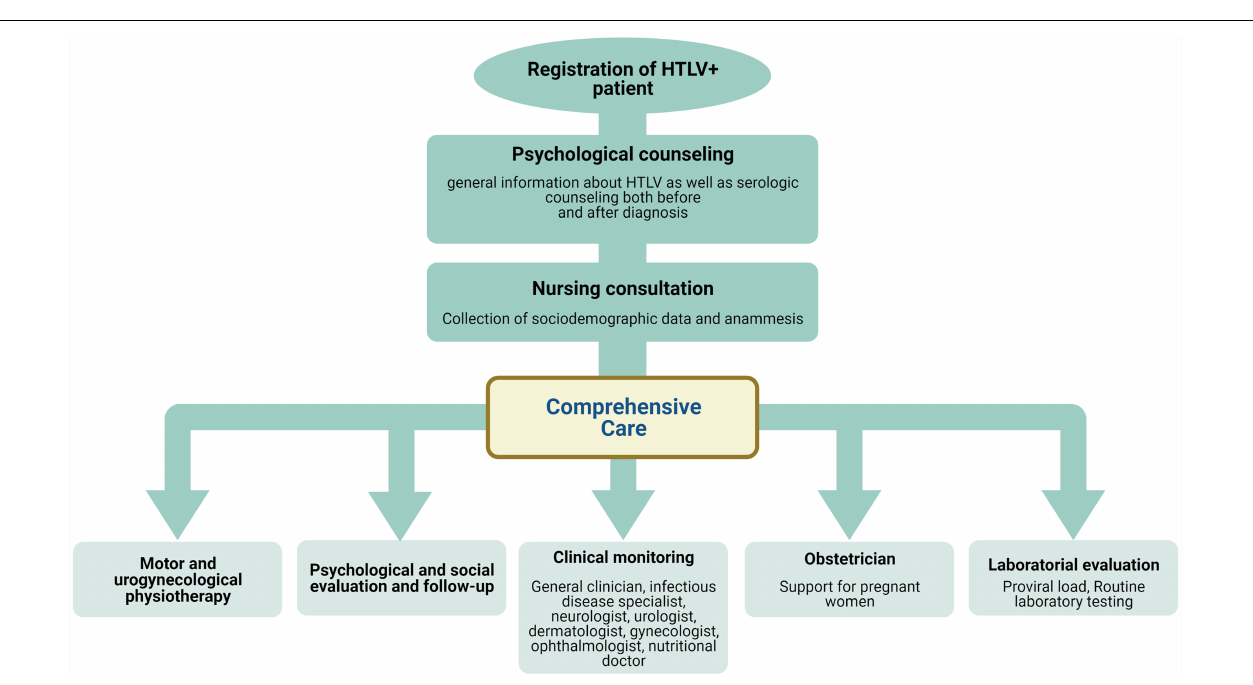
FIGURE 2 | Flowchart detailing biopsychosocial comprehensive care for HTLV-1-infected individuals followed at Integrative Multidisciplinary HTLV Center